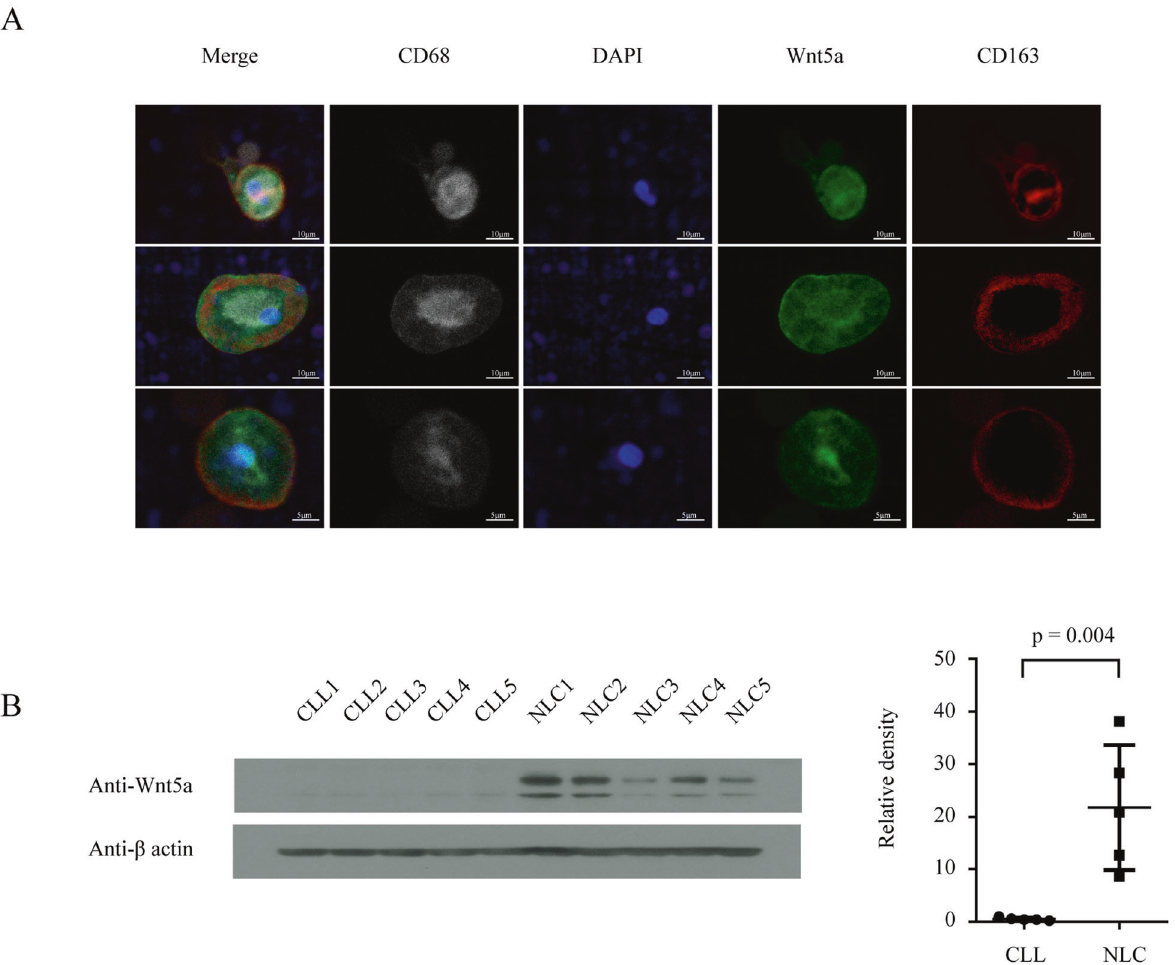
Fig. 2 NLCs but not neoplastic leukemia cells express Wnt5a. A Fluorescent microscopy of Wnt5a expressed by NLCs. CD163 and CD68 were used as markers for NLCs. B Immunoblot analysis of Wnt5a in paired NLCs and CLL cells. Dot fi gures represent ratios of densities (Wnt5a/ β -actin). Error bars denote standard deviation ( n =